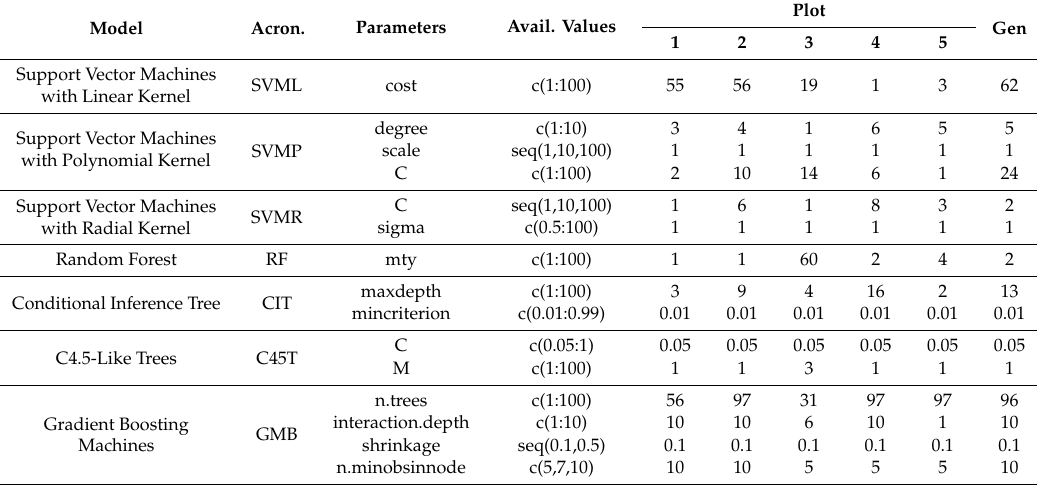
Table 2. The implemented machine learning models and their parameters. Abbreviations: Acron: acronym, Avail: available; Gen: general model.